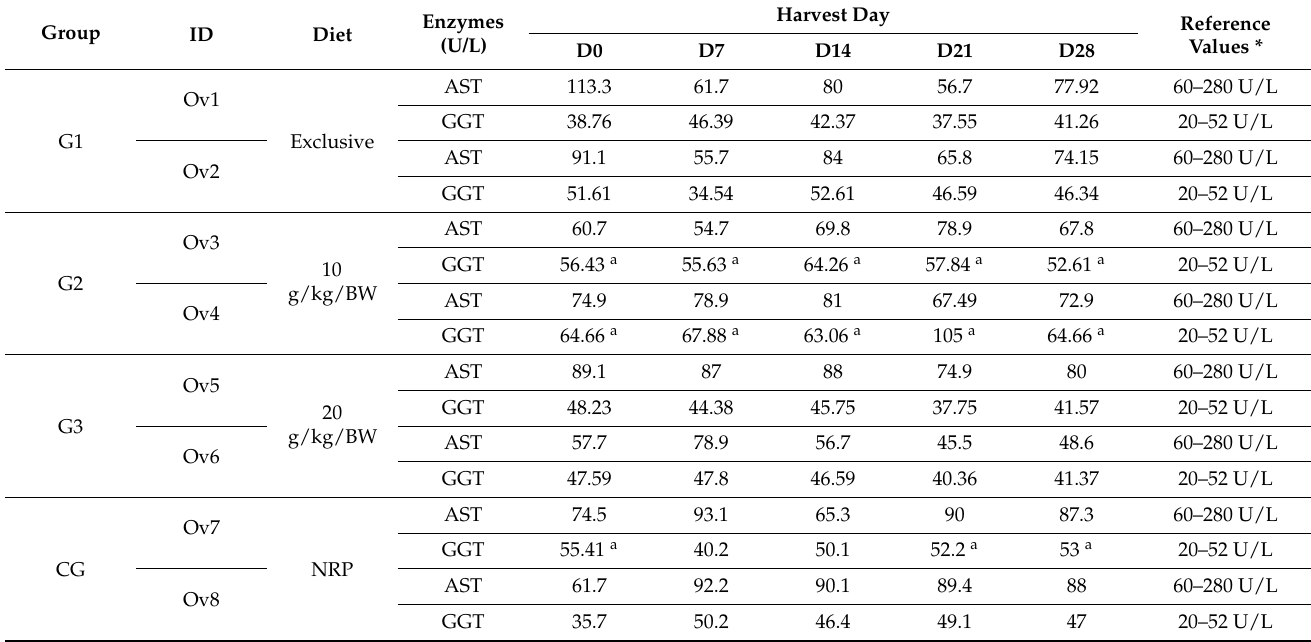
Table 3. Experimental poisoning by Chamaecrista serpens in sheep. Serum aspartate aminotransferase (AST) and gamma-glutamyl transferase (GGT) activities of six sheep experimentally intoxicated by Chamaecrista serpens